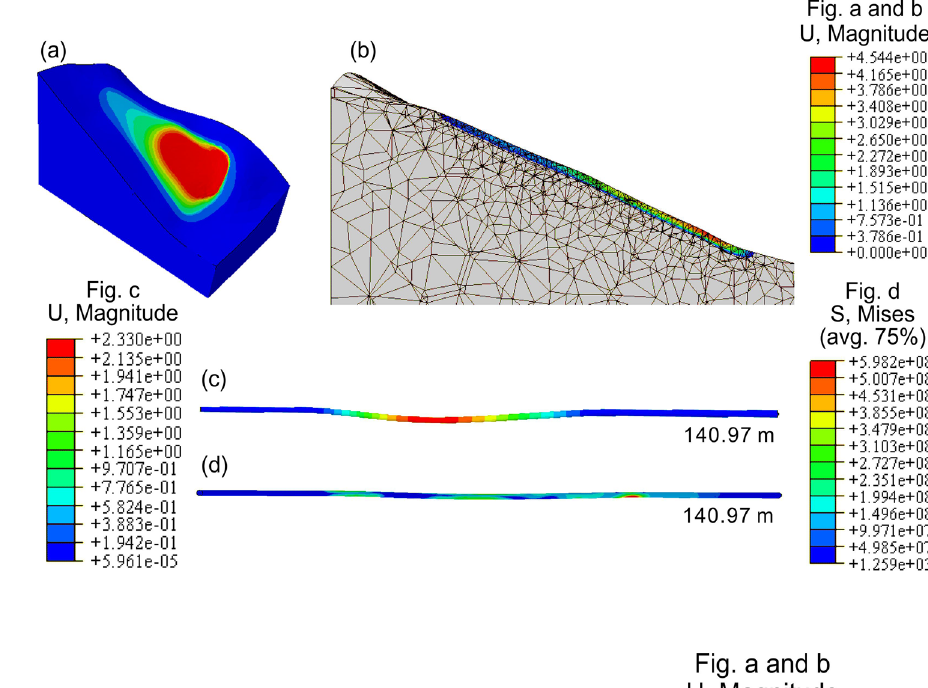
Fig. 10 Simulation results for the impact of the most danger- ous landslide on the pipeline. a Slope displacement; b slope profile displacement; c pipeline displacement; d pipeline stress